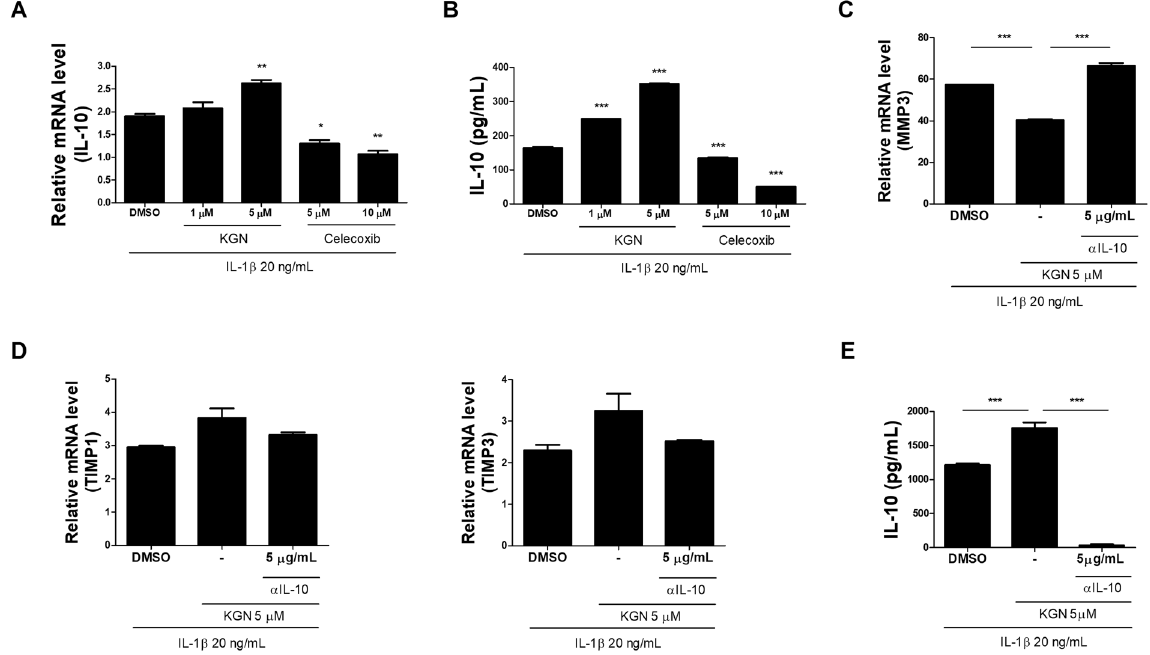
Figure 4. KGN upregulates the expression of anti-inflammatory cytokine IL-10. ( A ) Human OA chondrocytes were incubated with interleukin-1 β in the treatment of KGN for 2 days. The level of IL-10 anti-inflammatory cytokine gene was increased in OA chondrocytes after treatment with KGN. ( B ) IL-10 concentrations in culture supernatants were measured by using ELISA. ( C , D ) The mRNA levels of catabolic mediators, such as MMP3, and inhibitors, such as TIMP1, 3 were measured in OA chondrocytes after treatment with KGN. ( E ) The expression of IL-10 was measured by using ELISA. * P < 0.05, ** P < 0.001, *** P < 0.005, compared to the DMSO-treated